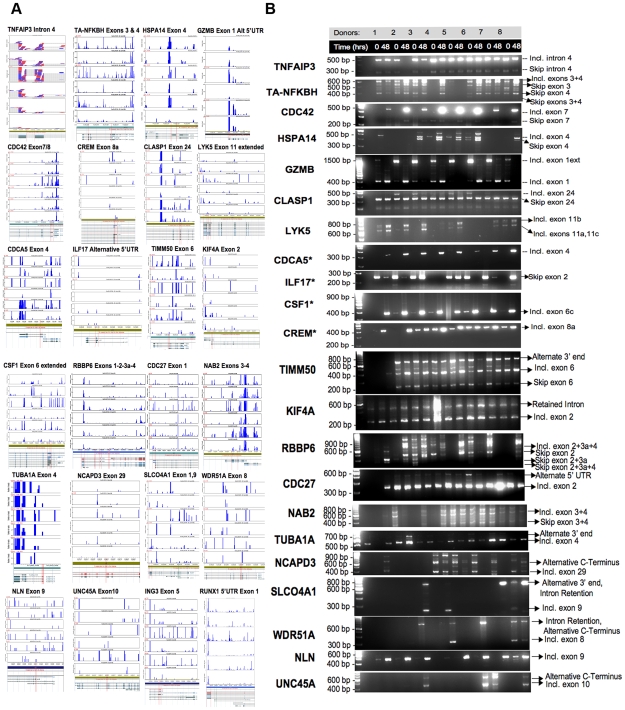
Validation of differentially alternatively spliced gene candidates in activated T cells between 0 and 48 hours.(A) GenomeStudio view of 24 of 32 total candidate AS genes, 17 validated by PCR and 7 candidates chosen as examples of those that were not PCR validated. Genomic stacked alignment plots with top 3 rows representing samples 3 to 1 (top to bottom) at T0 and bottom 3 rows representing samples 3 to 1 at T48, respectively. The y-axis represents the number of reads and the height of each bar is determined by calculating the overlapping sequence tags for each base-pair in a 4 pixel wide region and taking the maximum value. Splice junctions, when shown, are indicated by the grey dotted lines. Exons of interest are bordered by red vertical lines. Ensemble transcript splice variants are shown below for known annotated splice isoforms. (B) RT-PCR validation of 24 of 32 total candidate AS genes, 17 validated by PCR and 7 candidates chosen as examples of those that were not PCR validated. PCR was performed with primers to the neighboring constitutively expressed exons and the products were resolved on 2.5% agarose gels. Gene symbols are listed on the right, time points and donor for each sample are listed in the top 2 panels, and observations of splice events for indicated exons are given to the right (incl  =  exon retained, skip  =  exon spliced). Star next to a gene name indicates that the validation results did not show the predicted splice variants. 100 bp ladder is visualized in the left-most lane. Unmarked bands most likely represent minor splice variants, heteroduplexes or RT-PCR artifacts.